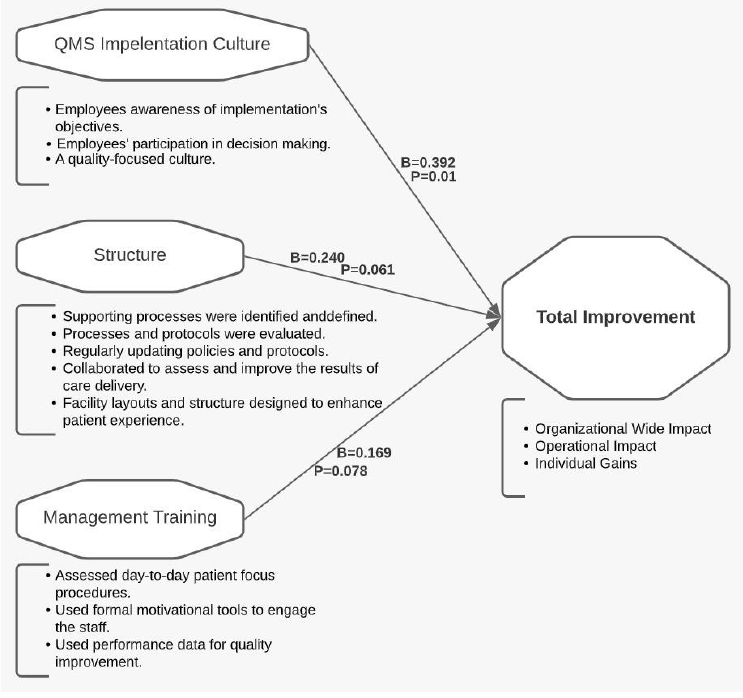
Figure 1. Implementation model.